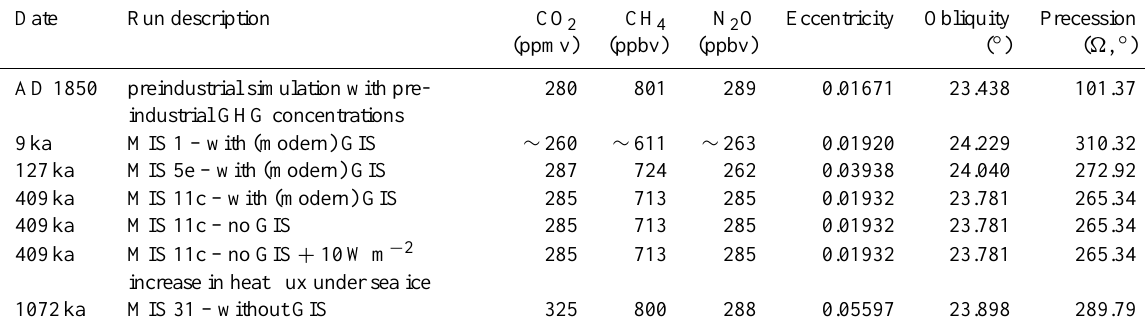
Table 1. Overview of interglacial simulations performed during this study. Orbital configurations are from Berger (1978) and greenhouse gas (GHG) concentrations from Hönisch et al. (2009), Loulergue et al. (2008), Lüthi et al. (2008) and Schilt et al. (2010). Modern GHG concentrations are taken from AD 1950; obliquity and precession ( (cid:127) ) are given in degrees.